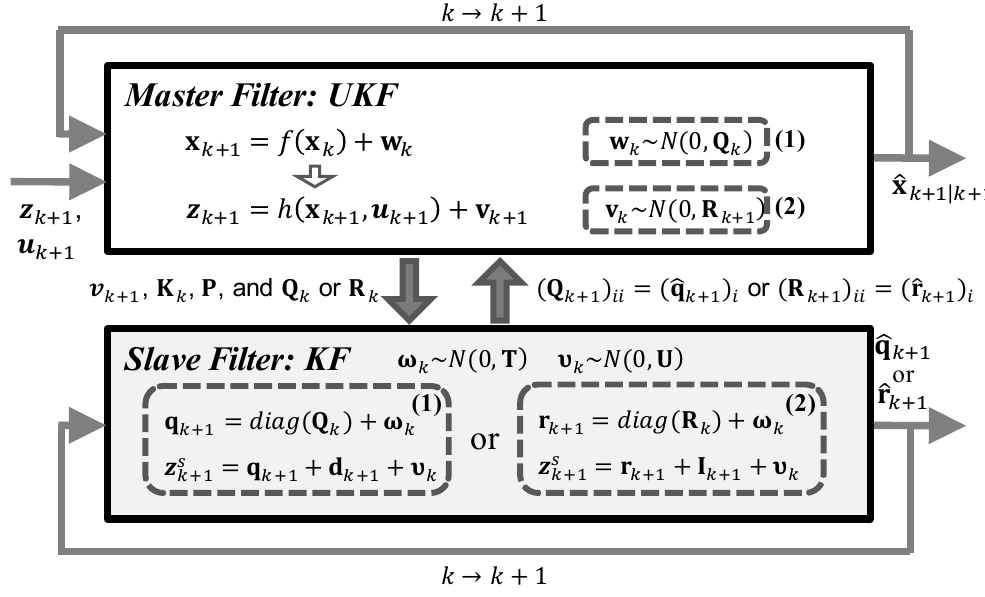
Figure 2. General block diagram illustration of Master-Slave Kalman Filters.